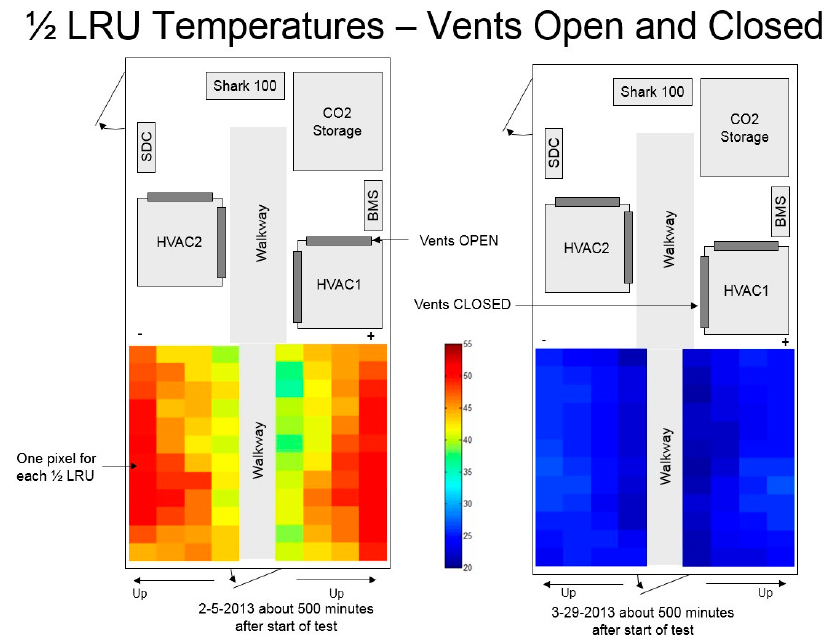
Figure 15. Temperature of the battery modules (two groups of seven cells, ½ of a LRU) for different configuration of the HVAC1 vents. Units are degrees Celsius.